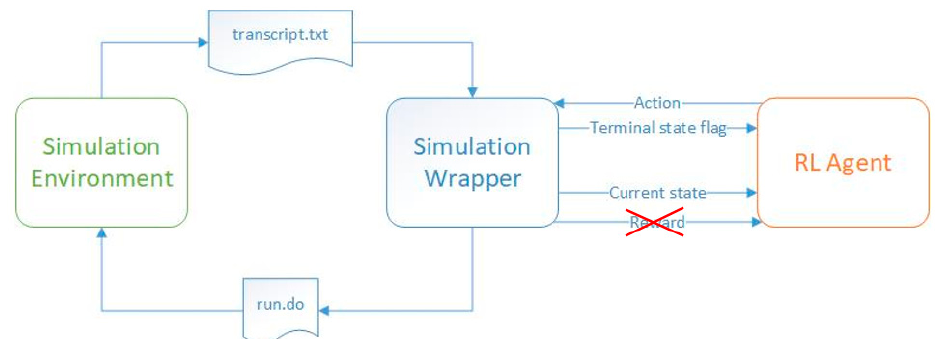
Figure 2. Information transferred between the code representing the reinforcement learning agent and the simulation environment containing the DUT during the inference process.